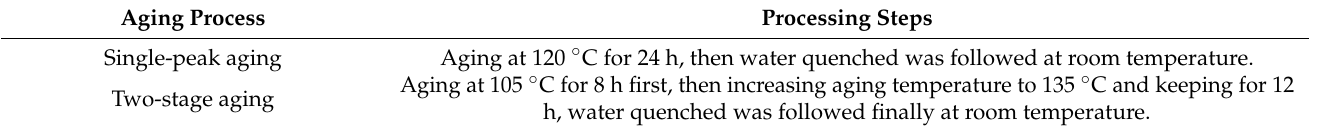
Table 2. The processing steps of single-peak aging and two-stage aging. Aging Process Processing Steps Single-peak aging Two-stage